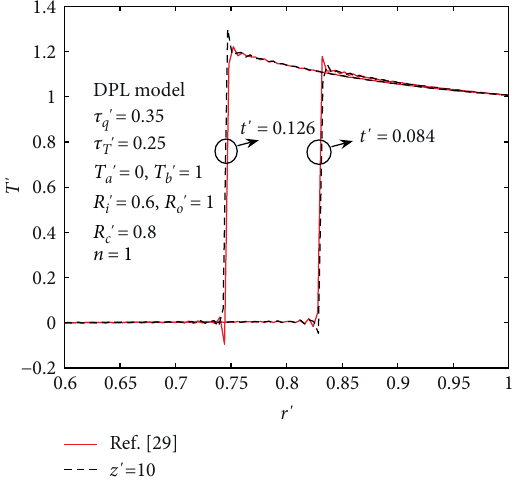
Figure 2: Comparison of temperature distribution away from the crack with the result in [39].